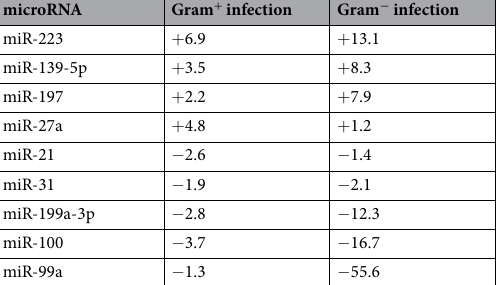
Table 1. Identification of infection-associated microRNAs using Taqman Low Density Arrays. 10 effluent samples each were pooled from stable non-infected individuals and from patients presenting with acute peritonitis that was subsequently confirmed as coagulase-negative Staphylococcus (Gram + ) or E . coli infections (Gram − ), and analysed using TLDA. microRNA levels in each group were normalised to the global expression levels across the plate, and are shown as relative values compared to levels in stable individuals as reference (set to 1.0). Only microRNAs that could be detected in all three groups were included in this